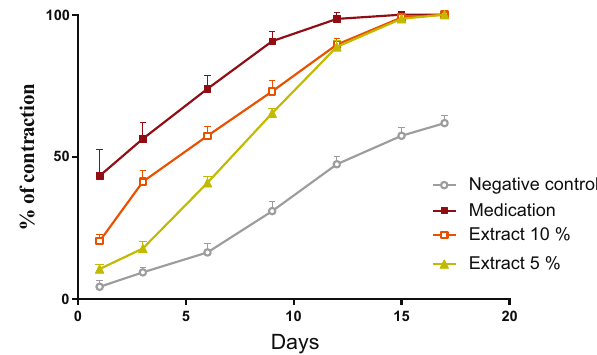
Figure 9: Evolution of the average percentage of animal burns: medication, extract 10%, extract 5%, and negative